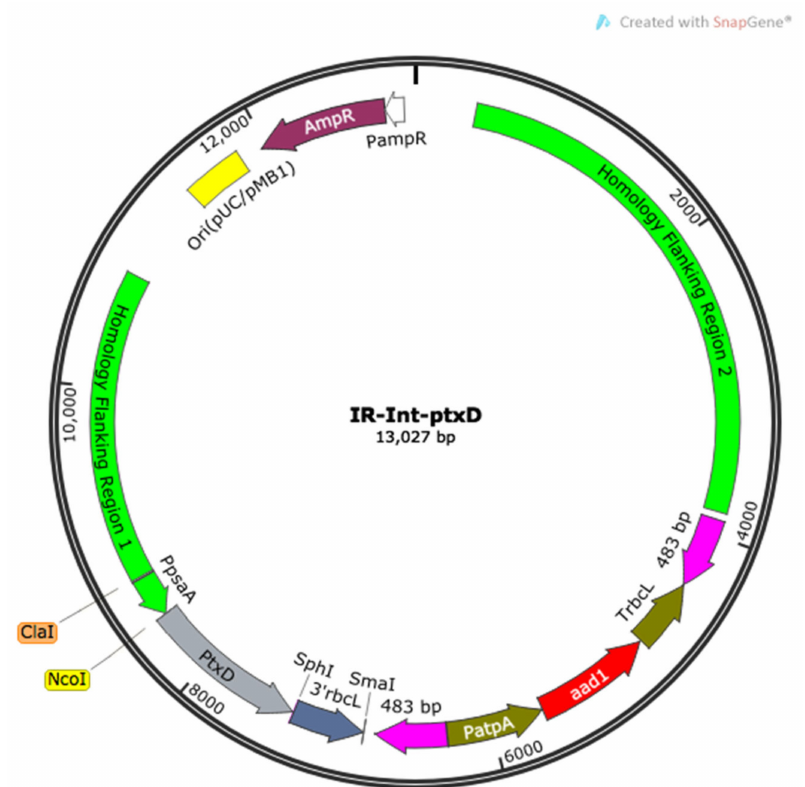
Figure 1. Map of the assembled IR-Int vector carrying the phosphite dehydrogenase ( ptxD ) transgene that was used in this work to transform the plastome of the wild type T222 strain. This vector contains two flanking regions required to enable the homologous-recombination based transgene insertion at the level of the inverted repeats of the chloroplast genome of the alga and the recyclable selectable marker gene aadA [22], providing resistance against the antibiotic spectinomycin. The PTXD gene was optimized according to the AT-rich codon bias of the chloroplast genome of C. reinhardtii and placed under the transcriptional control of the cis-acting elements pair psaA promoter and rbcL 3 (cid:48) untranslated region (UTR) and terminator via a subcloning step through the AtpB-int vector. A mutagenized version of the PTXD enzyme, carrying the substitution of the two adjacent residues Glu-175 and Ala-176 with Ala and Arg, respectively, was produced via site-directed mutagenesis and introduced in the same vector configuration (hereinafter referred to as ptxD E175A-A176R